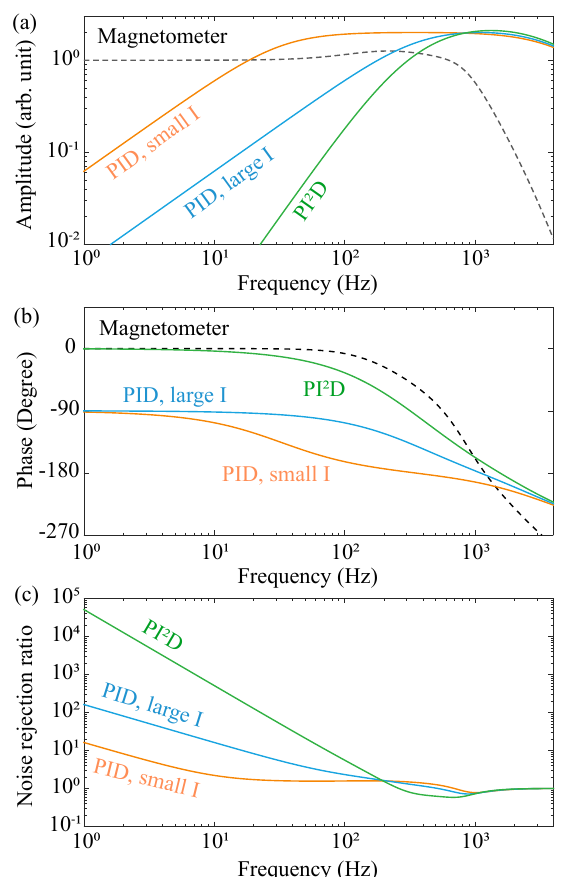
Figure 2. Optimization of the active magnetic-field stabilization system. ( a ) Amplitude–frequency responses of the feedback controller and the magnetometer. ( b ) Phase–frequency responses of the feedback controller and the magnetometer. ( c ) The calculated noise rejection ratios under different parameter settings of the feedback controller. The dashed black lines in ( a , b ) are the calculated amplitude- and phase- frequency responses of the magnetometer. The solid lines in ( a , b ) are the calculated amplitude- and phase- frequency responses of − 1/ [ FB ( s ) × MG ( s )] . Different colors of the lines indicate different parameters of the feedback controllers, i.e., orange (blue) for a PID module with a small (big) integration coefficient K I , and green for a PI 2 D